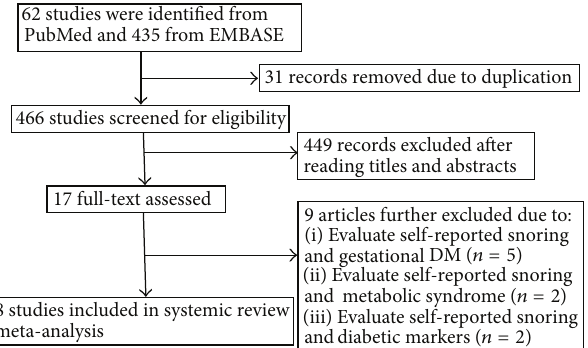
Figure 1: Flow chart of the literature search and study selection process.